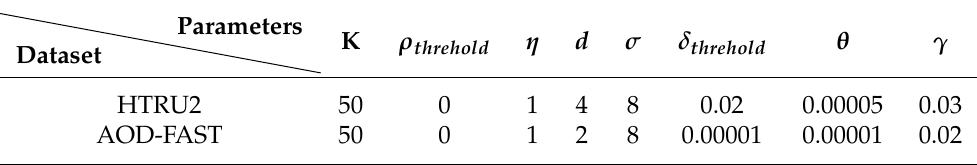
Table 6. Some parameters setting of PHCAL for HTRU2 and